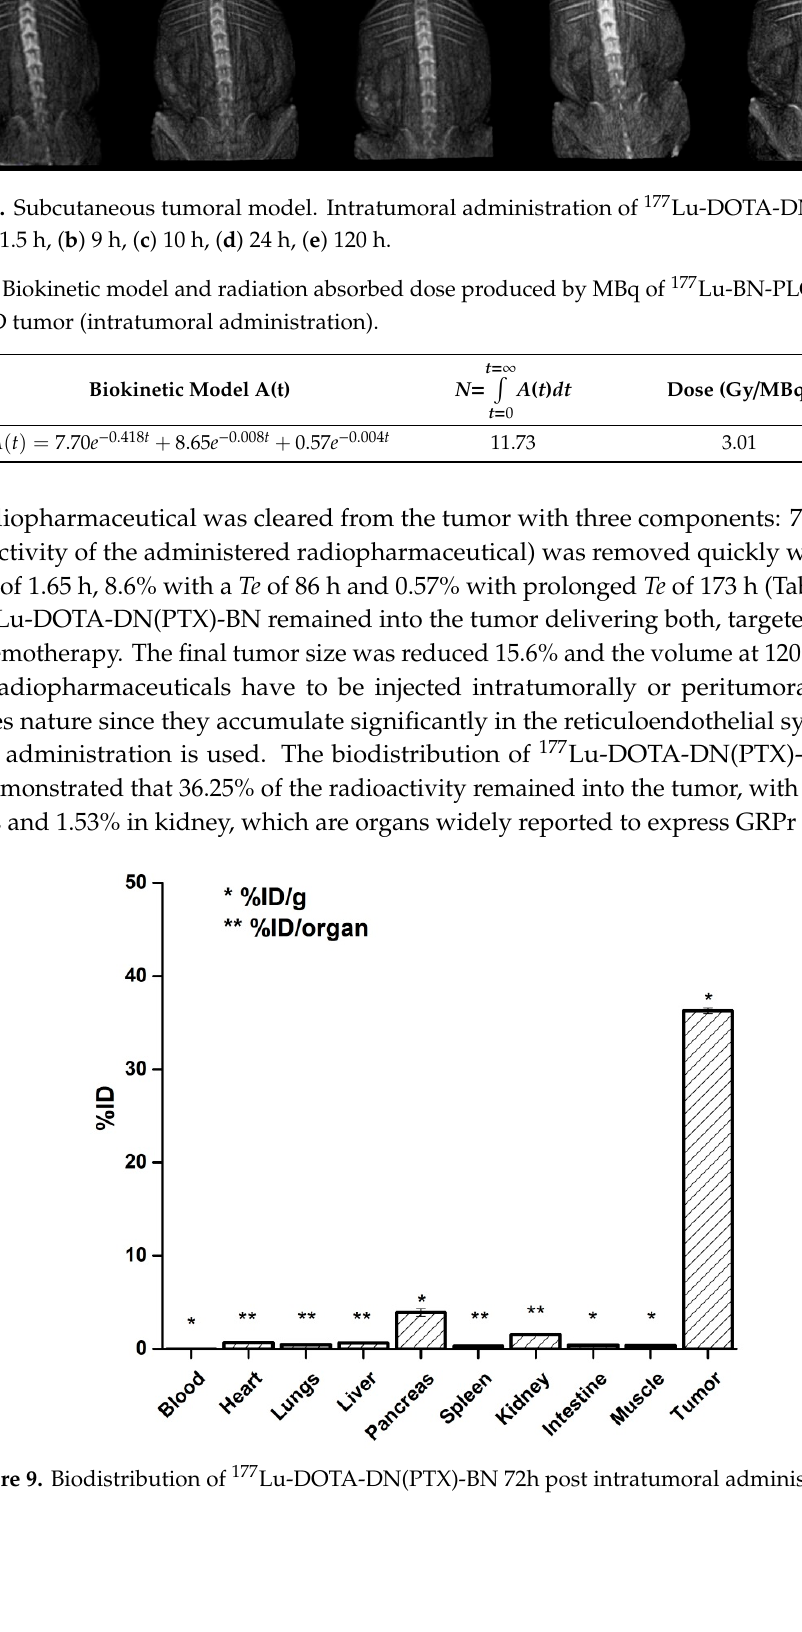
Figure 9. Biodistribution of 177 Lu-DOTA-DN(PTX)-BN 72h post intratumoral administration.